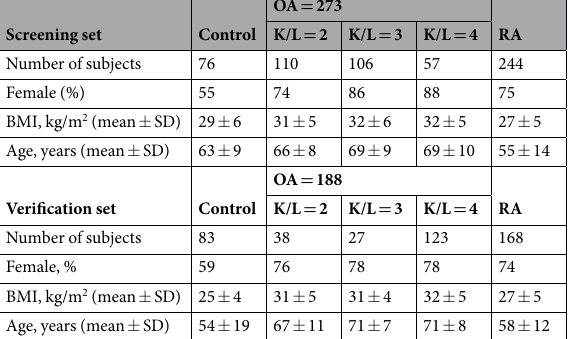
Table 1. Clinical characteristics of the patients and control subjects used in the study. BMI, indicates body mass index; K/L, Kellgren-Lawrence score and SD, standard